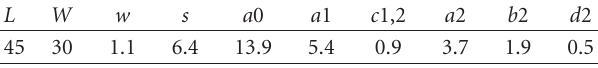
Table 2: Proposed coupler dimensions